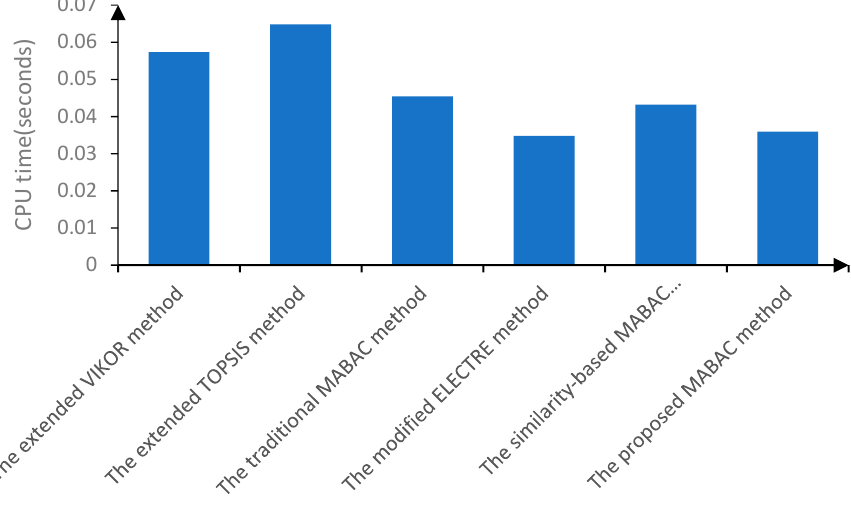
Figure 5. Comparison results in terms of CPU time.